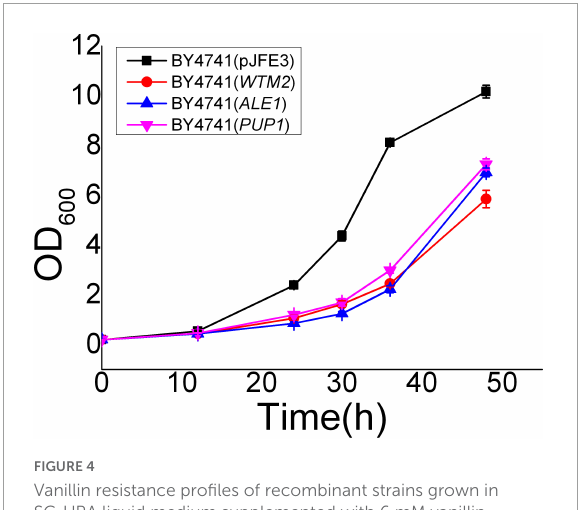
FIGURE4 Vanillin resistance profiles of recombinant strains grown in SC-URA liquid medium supplemented with 6 mM vanillin. Cultivations were performed at 30 ◦ C. All the data were mean value ± standard deviation of independent